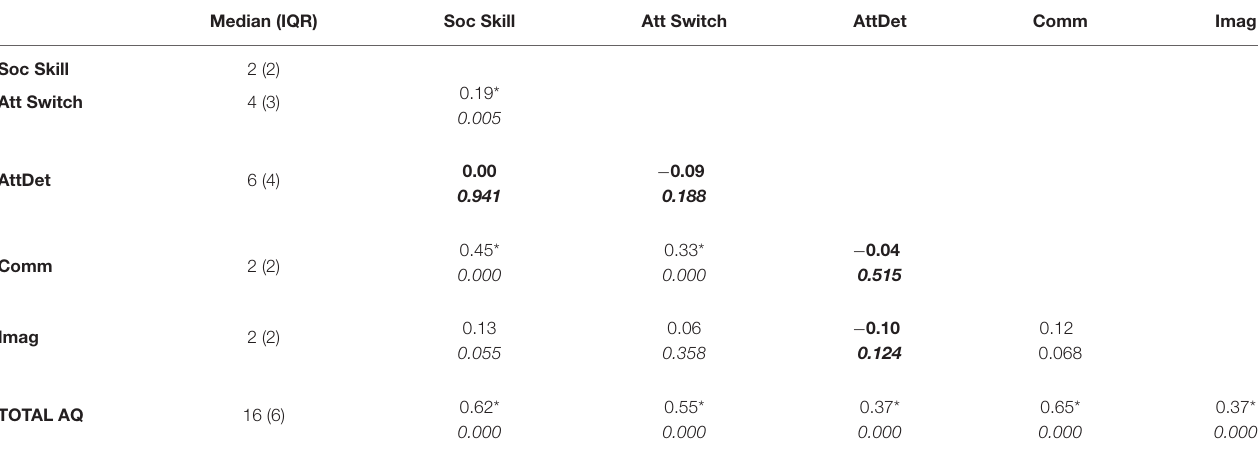
Correlation tests involving the Attention to Detail scale are highlighted with bold font. Soc Skill, Social Skill scale of the AQ questionnaire; Att Switch, Attention